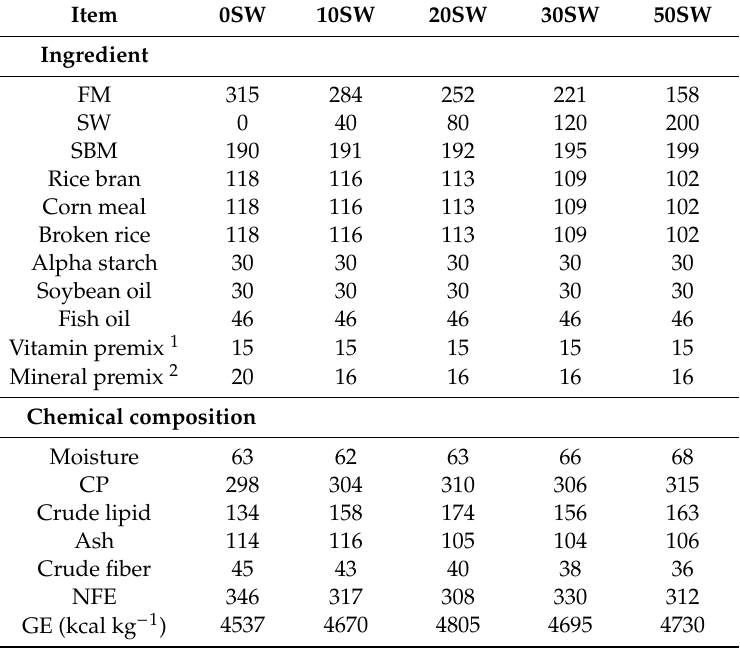
FM, fish meal; SW, stick water; SBM, soybean meal; CP, crude protein; NFE, nitrogen-free extract; GE, gross energy. 1 Vitamin premix; 1 kg contained 12,000 U vitamin A, 2000 U vitamin D, 3000 mg vitamin E, 20 mg vitamin